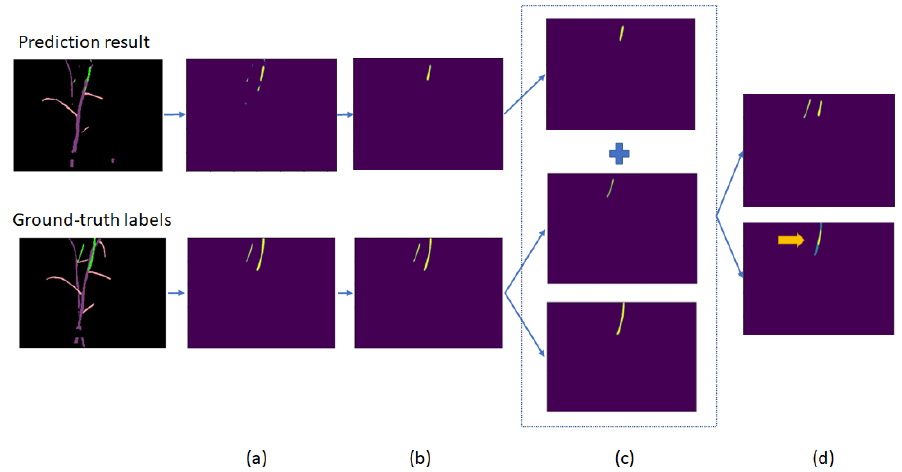
Figure 9. Four steps of detecting the right sucker prediction. ( a – d ) is the result of step 1, step 2, step 3, and step 4, respectively. The yellow arrow shows the collapse of the prediction label and ground-truth label. In this case, one true sucker is found.